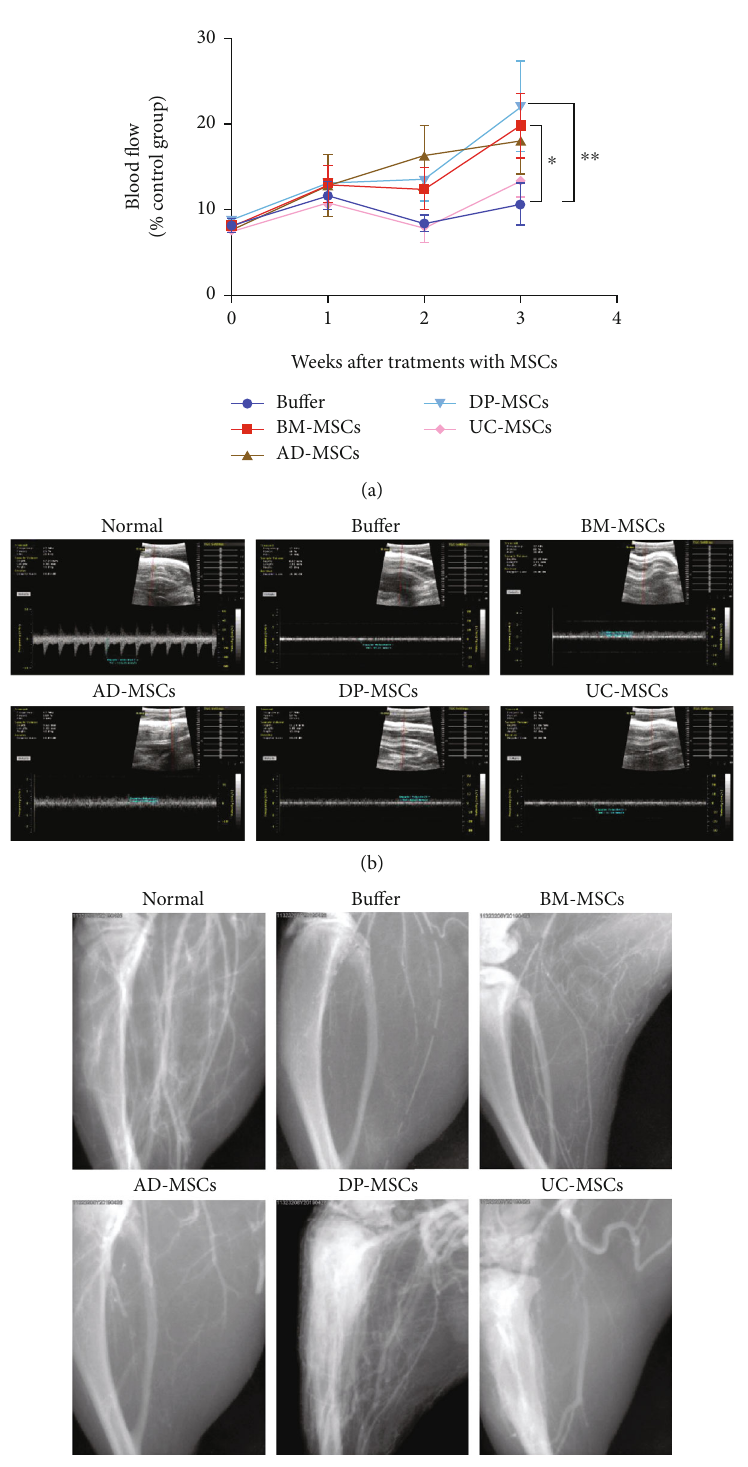
Figure 2: The blood perfusion and angiogenesis at ischemic limb after treatments with MSCs. Immediately after ligation and at 1, 2, and 3 weeks after cell transplantation, the blood perfusion was measured at the proximal side of ligation by laser Doppler perfusion imaging. The perfusion ratios of the ischemic limb :nonischemic limb were calculated and are presented in (a), and the representative images are shown in (b). At 4 weeks after MSC transplantation, the left femoral artery was separated from the groin to the knee joint and the proximal side was ligated. An artery catheter was inserted into the femoral artery from the distal side. Immediately after 0.6 to 0.8ml iodoprolamine injection, the vascular network was observed through a continuous photograph by X-ray. The representative images are presented in (c). Data in (a) were shown as mean ± s : e : m . ∗ p < 0 : 05 , ∗∗ p < 0 : 01 compared with the corresponding